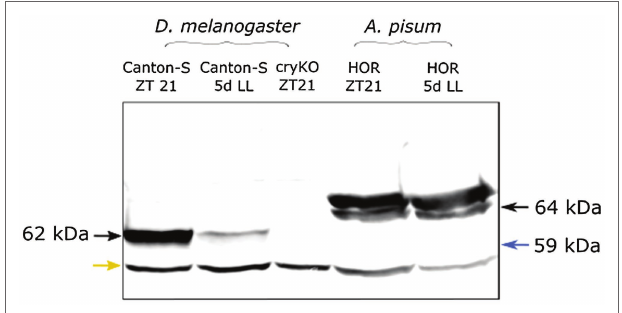
FIGURE 1 | The Drosophila CRY1 antibody appears to detect aphid CRY1. As expected, the Drosophila anti-CRY1 recognizes one single band in the Drosophila head extract. Under constant light (5d LL), the signal decreased because of CRY1 degradation by light. In the cryKO mutant, the signal was absent. The same antibody detected two bands in the aphid head extract [one of them is at the expected height of aphid CRY1 (64 kDa) and the other is at 65 kDa]. We do not see any band at 59 kDa (blue arrow) where we would have expected CRY2. When aphids are reared for 5 days under constant light (5d LL), the signal does not decrease, suggesting that the amount of CRY protein does not change. The lower band in all lanes likely results from unspecific binding (yellow